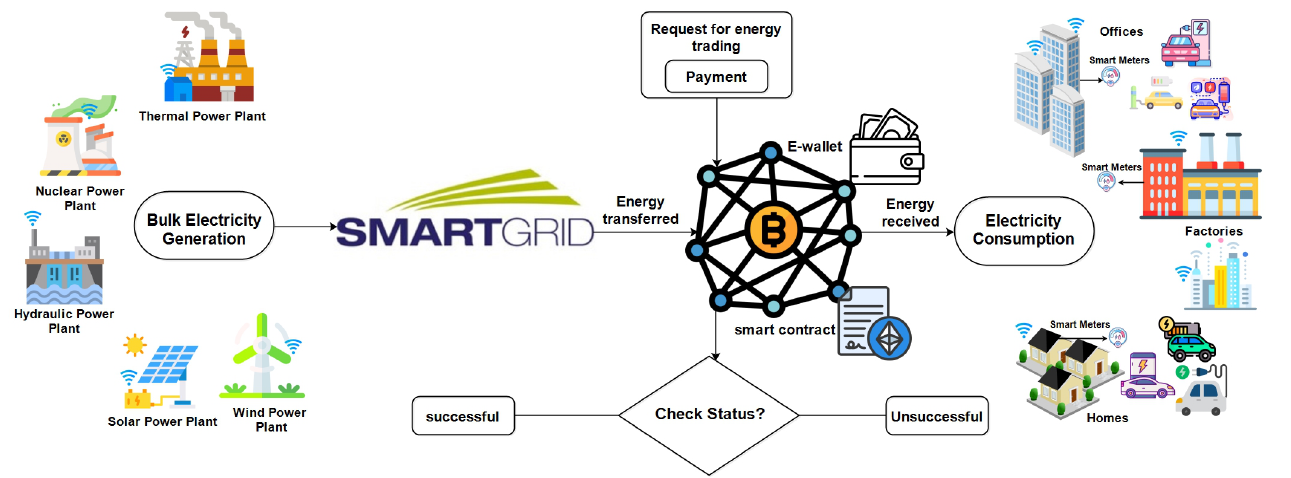
Figure 5. Adoption of blockchain in smart grid for secure energy